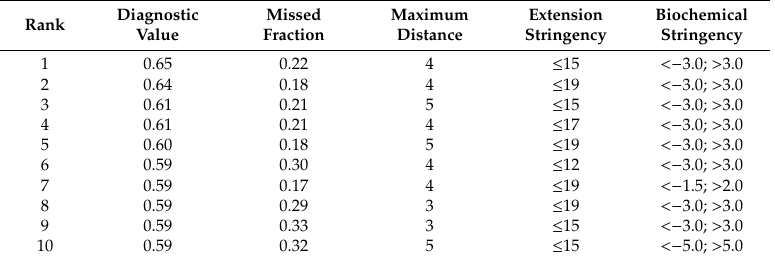
Table 1. Most favorable parameter combinations for the cross-omics method.